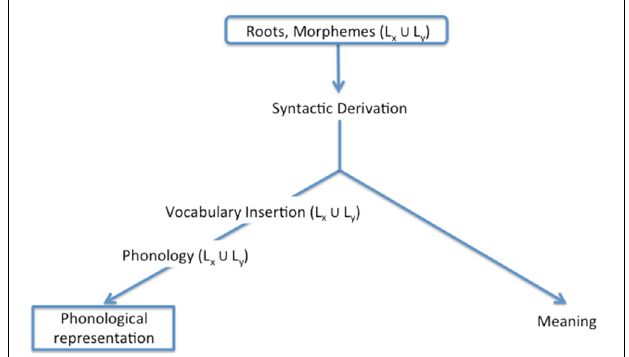
FIGURE 1 | Synthesis model (Lillo-Martin et al., 2012; Quadros et al.,